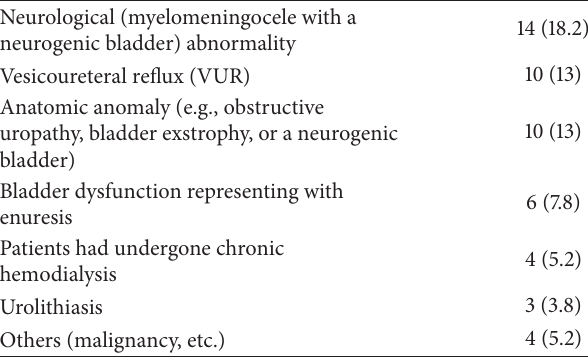
Table 1: Predisposing factors for urinary tract infection, 𝑛 (%).